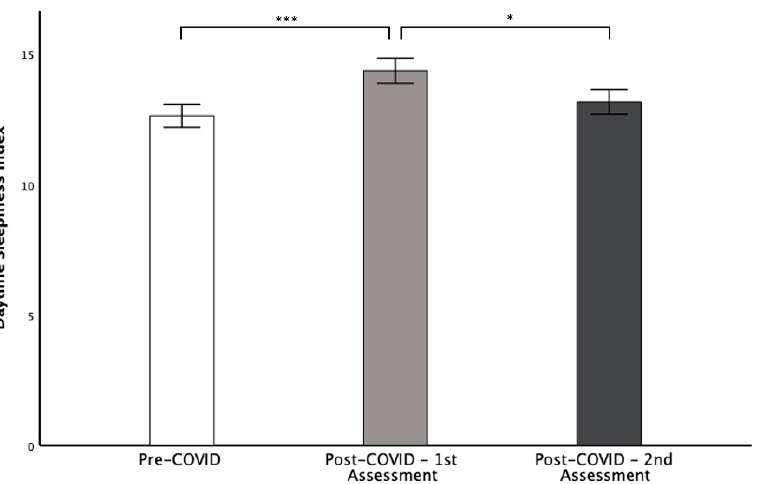
Figure 1. Total CSHQ-DE score pre-COVID-19 vs. post-COVID-19 initial and re-presentation. The sleep disturbance score significantly increased between pre-COVID-19 and 1st assessment (45.82 ± 8.7 to 49.40 ± 8.3, respectively), then decreased (46.98 ± 7.8). Univariate ANOVA with multiple meas- urements, post hoc Bonferroni (** p ≤ 0.01). Of note, the CSHQ-DE subscale score “daytime sleepiness” significantly increased from pre- to post-COVID-19 (13 ± 3.0 vs. 14 ± 3.2, respectively; p ≤ 0.001) and significantly decreased again at the follow-up (13 ± 3.2; p = 0.029) (Figure 2). All other subscale scores of the CSHQ-DE did not display a change from pre- to post-COVID-19 (Table 5).